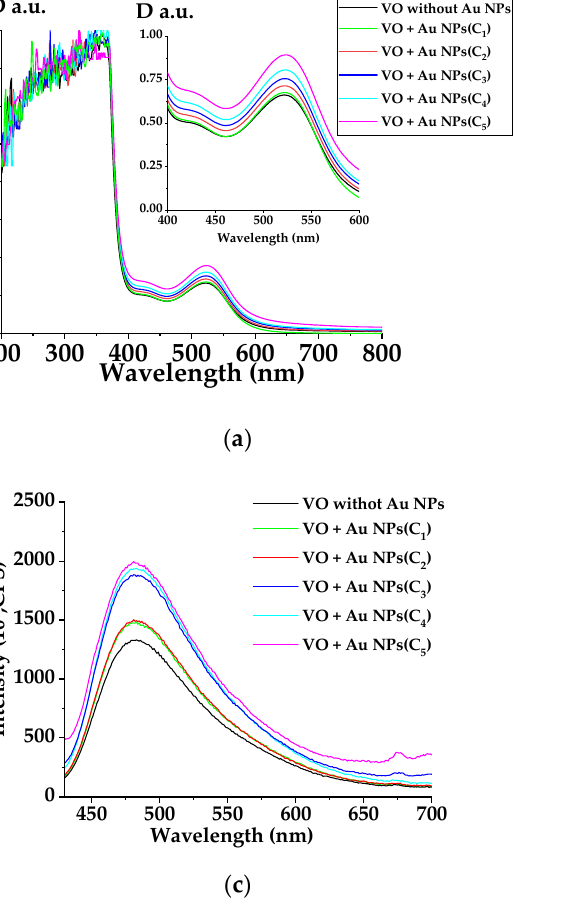
Figure 2. Optical characteristics. ( a ) Absorption spectrum of water–Eth VO extract with Au NPs of various concentrations C 1 = 1×10 −10 , C 2 =0. 75 × 10 −10 , C 3 = 0.5 × 10 −10 , C 4 = 0.25 × 10 −10 , C 5 = 0.125 × 10 −10 M. ( b ) Absorption spectrum of Au NPs in water (green curve) and in microemulsion (black curve), inset—SEM image of ablative Au NPs and size distributions. ( c ) Luminescence spectrum of water– Eth extract with Au NPs. ( d ) The dynamics of changes in the optical density and luminescence intensity of the extract on the concentration of Au NPs in the AOT reverse micelles at a wavelength of 480 nm.